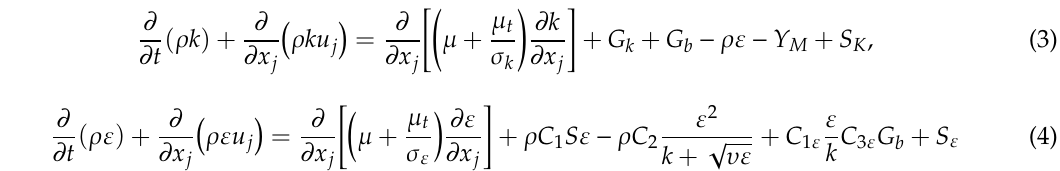
( a ) ( b ) Figure 4. Velocity contour of different external environment. ( a ) vacuum environment; ( b ) atmospheric environment. In a normal atmospheric environment, a supersonic jet will form a series of expansion fans at the exit of the nozzle, which will be reflected when reaching the jet boundary. Then a series of compression waves is formed and constitutes a Mach disk. When the compression waves travel downstream to the jet boundary, the occurrence of reflection induces new expansion fans. Repeated circulation forms a quasi-periodic shock cell structure, as shown in Figure 5. On a micro level, the generation, propagation and reflection of wave systems are essentially due to the collisions of a large number of molecules. When a certain point in the flow field is disturbed, the energy state of surrounding molecules and the probability of collision between molecules will be changed. Energy